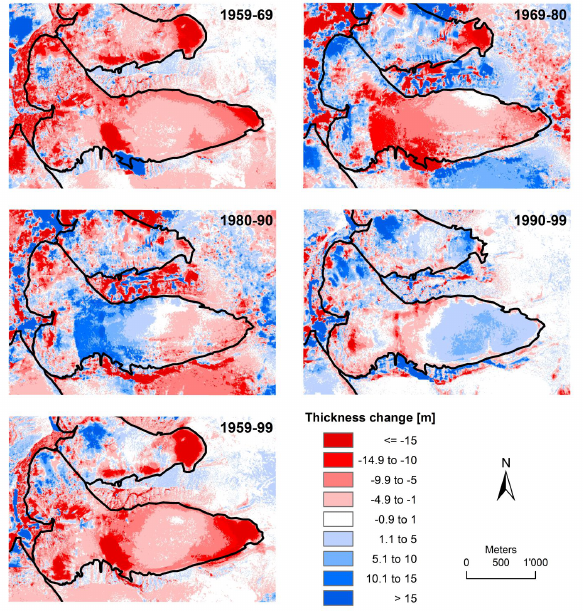
Fig. 4. DEM differences within and outside the outlines of Stor- glaci¨aren (in the centre), Isfallsglaci¨aren (adjacent to the north) and the northern edge of Bj¨orlings glaci¨ar (south-west of Storglaci¨aren) (black lines). The extent of the five figures corresponds to the bounding box as shown in Fig. 2. The differences are calculated by subtracting the earlier from the later DEM. The overall thickness loss (1959–99) originates from the strong ice loss in the first two decades, which was only slightly compensated for in the last two decades. Note the increased noise in the non-glacierized sections (i.e., upper left, upper right, and lower right corners) especially of the two images including the DEM of